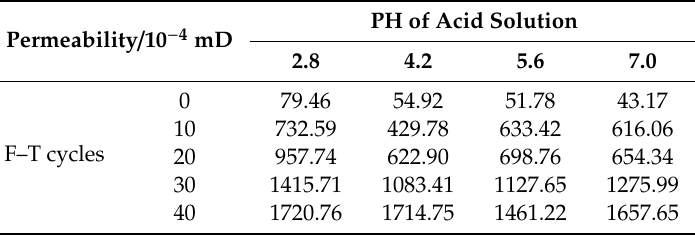
Table 1. Permeability of sandstone under di ff erent F–T cycles and acid solution.